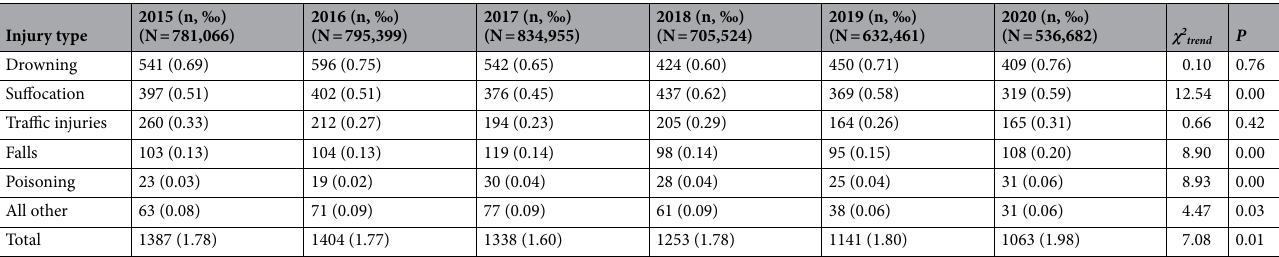
Table 3. Injury-related under-five mortality rate by year. N number of live births.